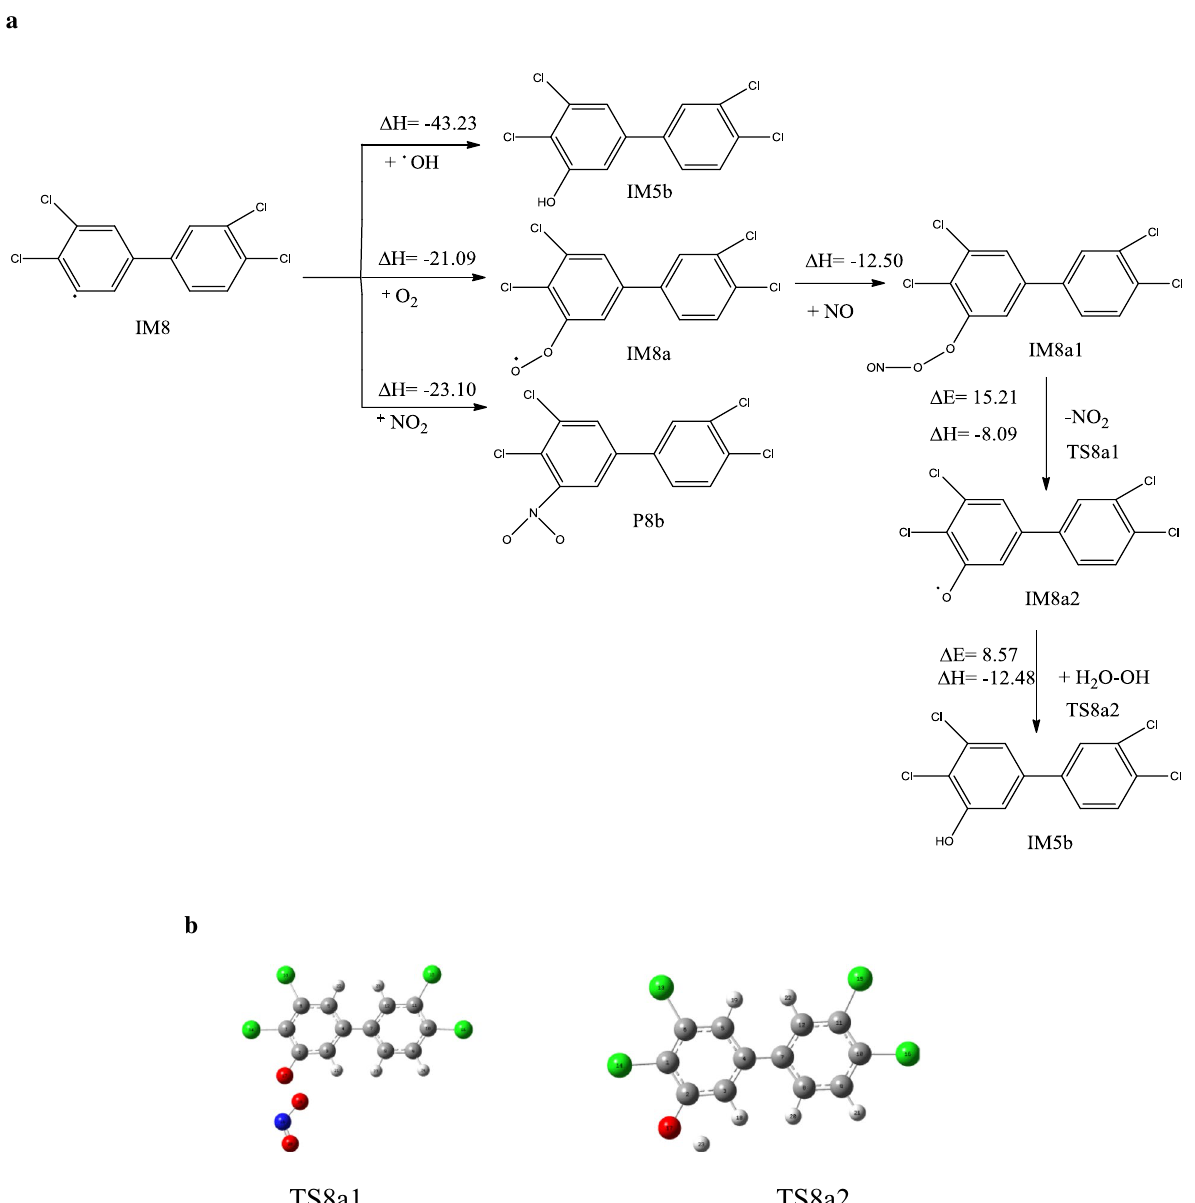
OH, O 2 , NO 2 ( a ) and the transition state structure of IM8a with NO ( b ). [∆E (kcal/mol): ·